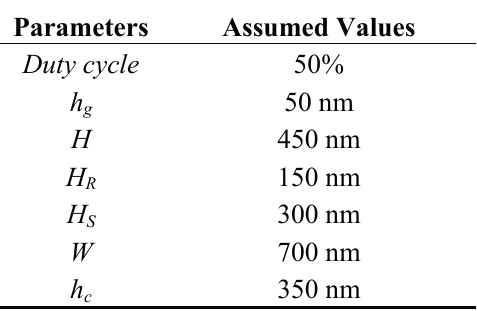
Table 2. Geometrical parameters used in